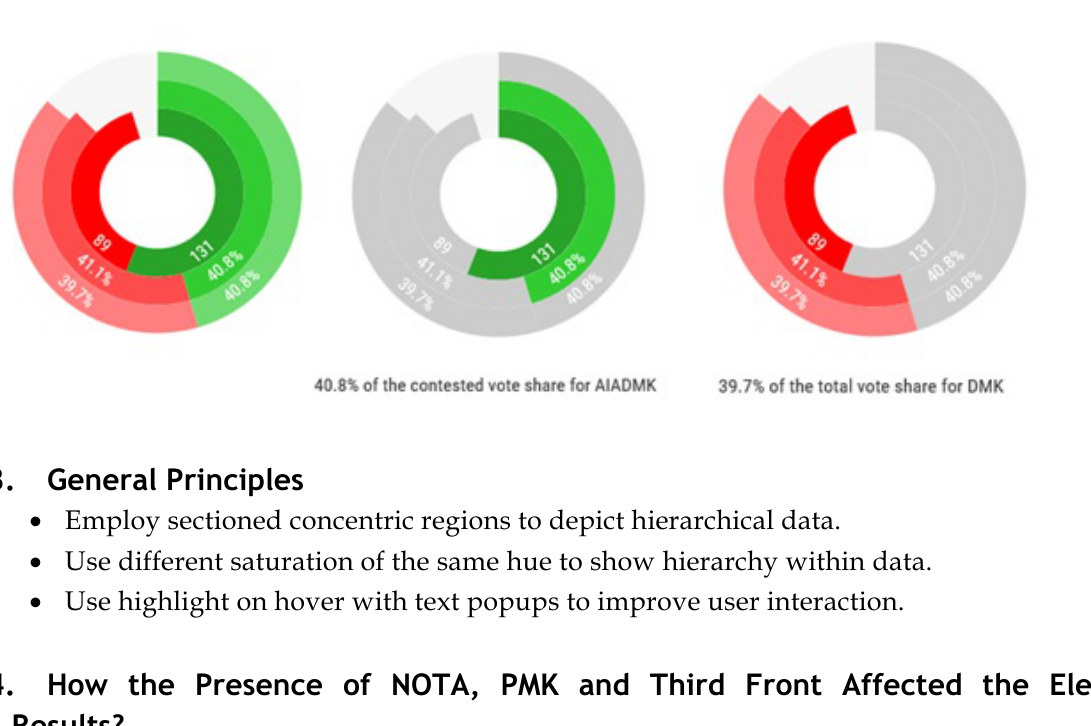
Figure 8: Winning Margins and Effect of NOTA Using Interactive Line